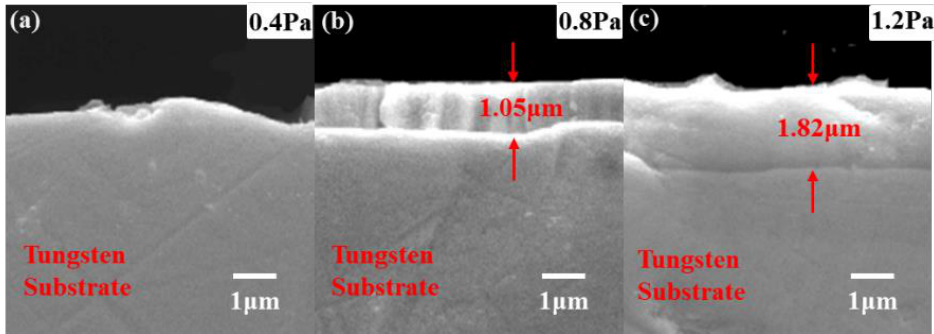
Figure 4. The SEM photographs of the Ta-Hf-C coating under different working pressures ( a ) 0.4Pa, ( b ) 0.8 Pa, and ( c ) 1.2 Pa.